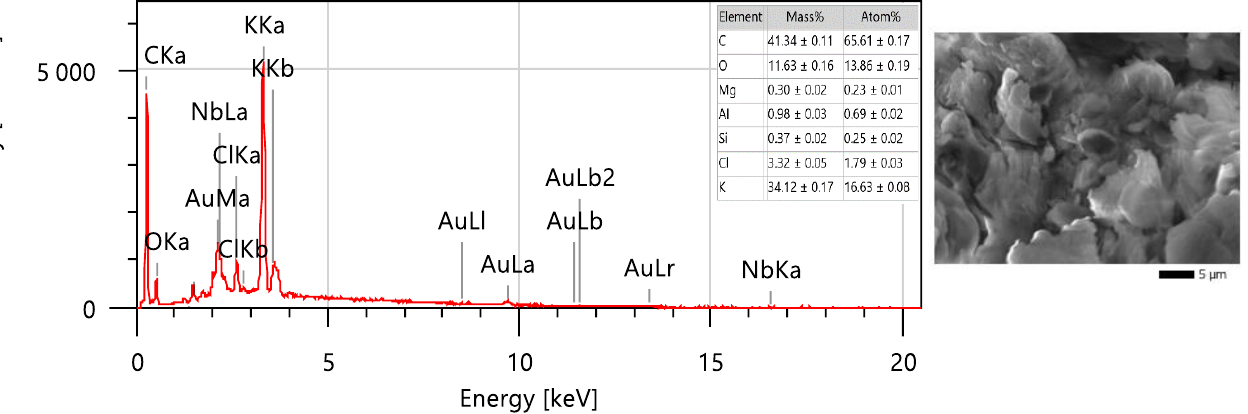
Figure 1. Scanning electron microscopy of almond bark at different magnifications: ( a ) × 250, ( b ) × 1000, ( c ) × 2000 and ( d ) × 4000.